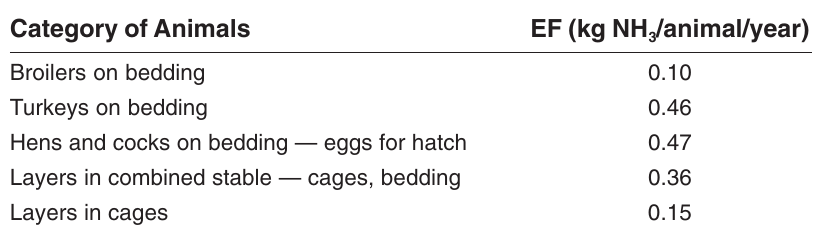
Emissions Factors for Poultry 3